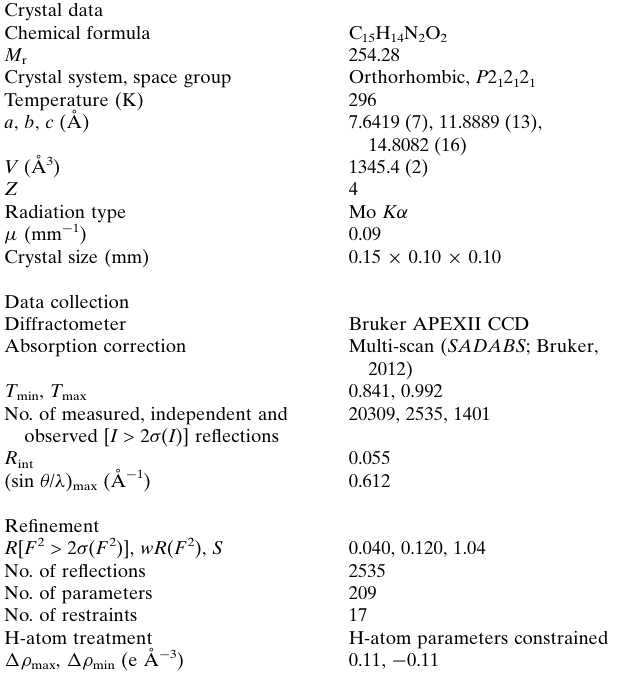
Table 3 Experimental details. Crystal data Chemical